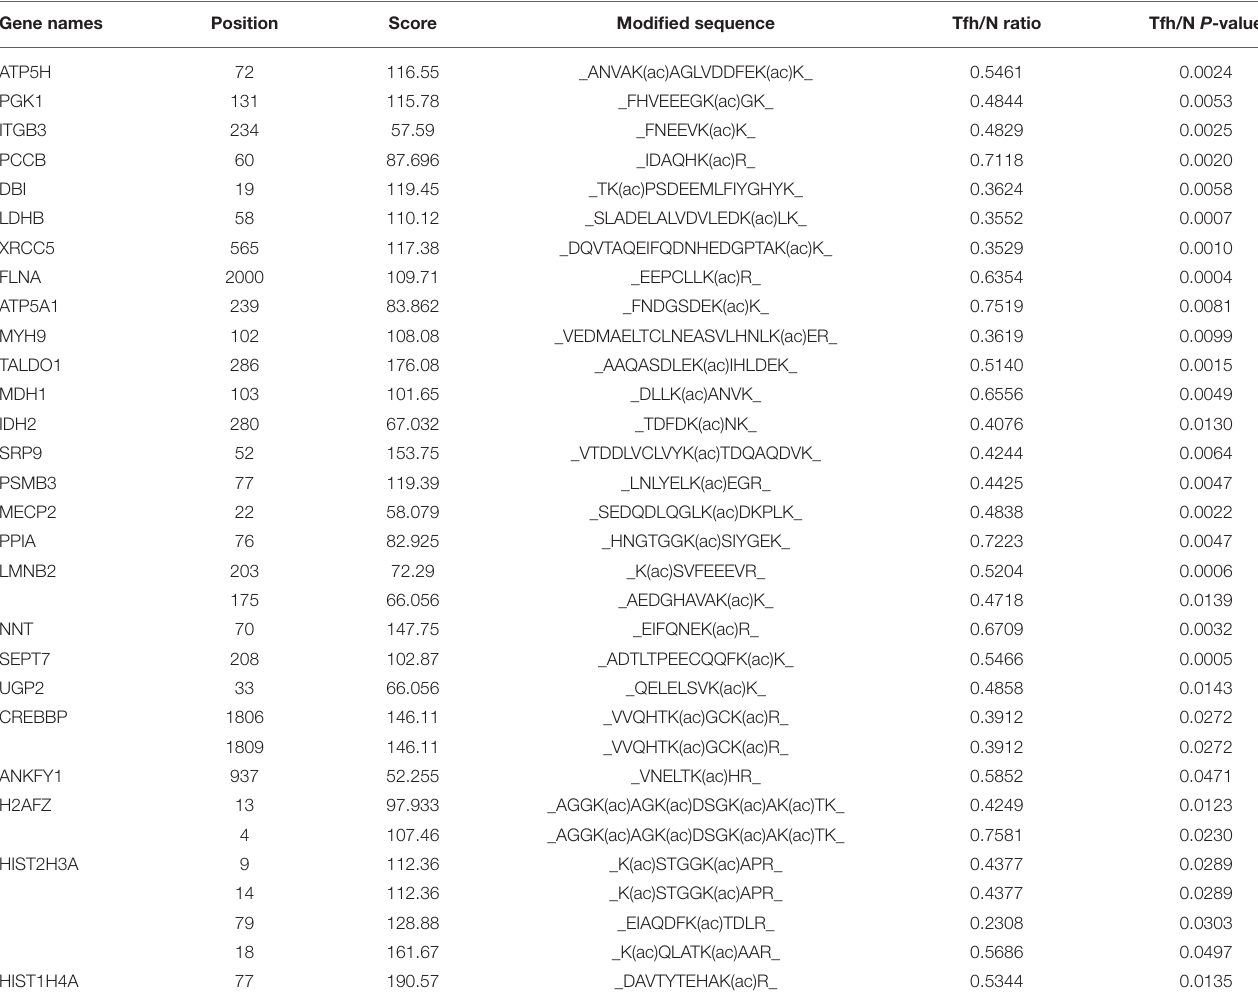
TABLE 2 | The information of 32 downregulated K acetylated residues corresponding to 26 proteins in iTfh cells compared to the naive CD4 + T cells was